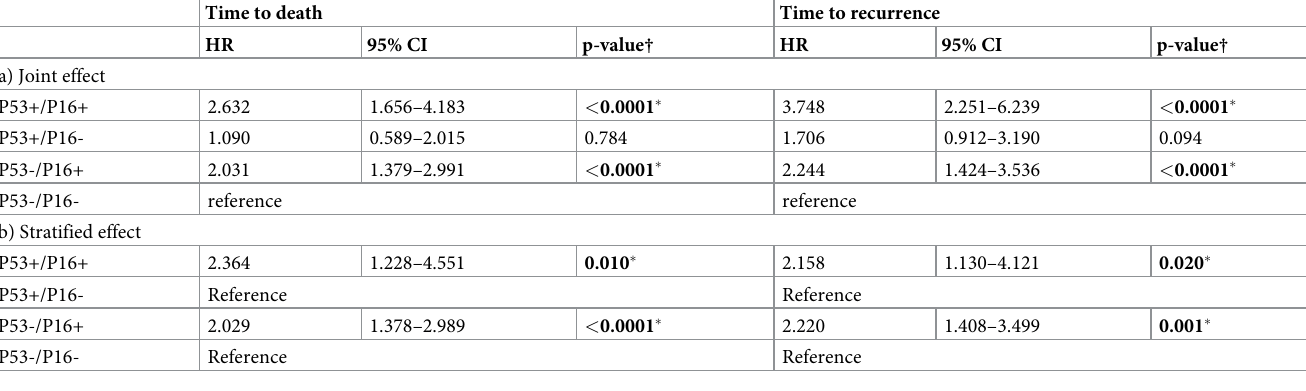
Table 5. Association of P53 and p16 status with overall and disease-free